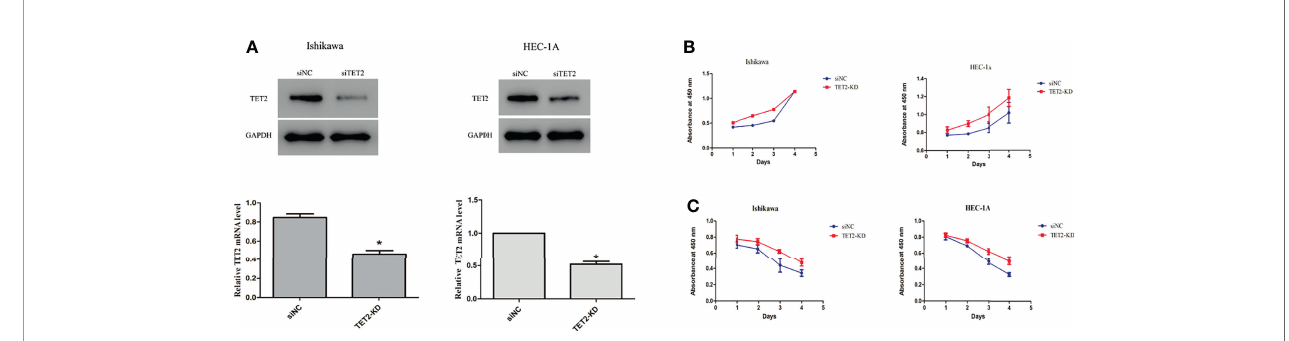
FIGURE 4 | Anticancer effects of TET2 in EC cell lines. The TET2 knockdown ef fi ciency of the gene-speci fi c siRNA was con fi rmed using western blotting and real- time PCR (A) . Knockdown of TET2 increased the proliferationin of EC cell lines (B) . The TET2 knockdown cells and control cells were treated with 5 mM metformin. The knockdown of TET2 attenuated the inhibitory effect of metformin on the proliferation of EC cells (C) . *P < 0.05, compared with